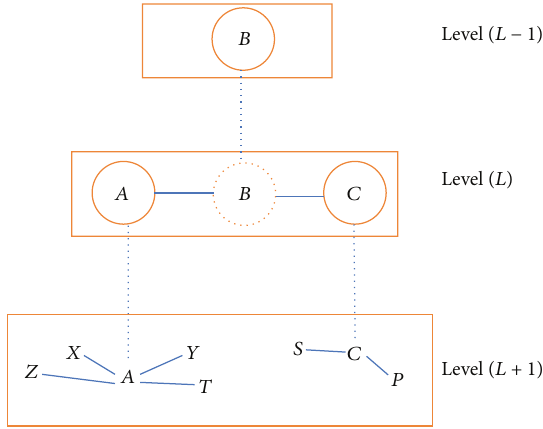
Figure 1: Hierarchal arrangement of peer